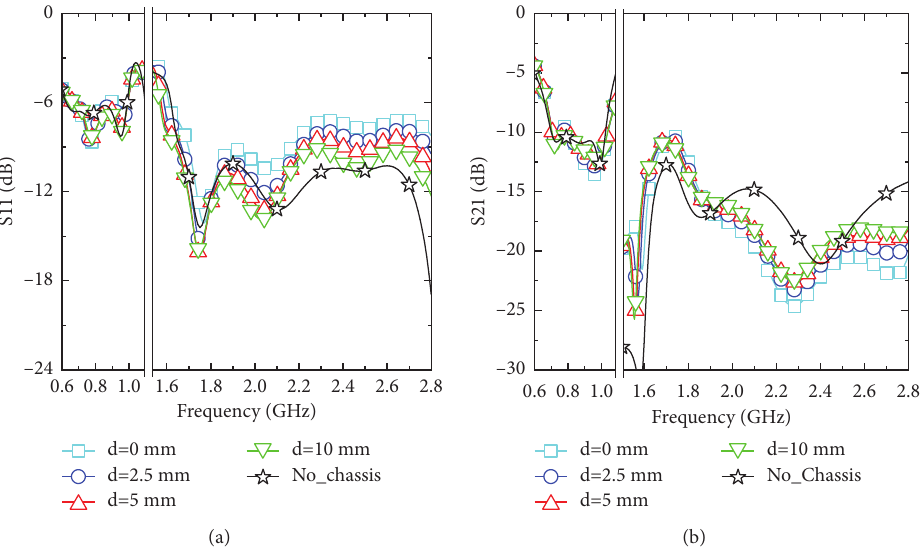
Figure 8: Effect of the chassis ground plane on the S-parameter. (a) S11. (b)